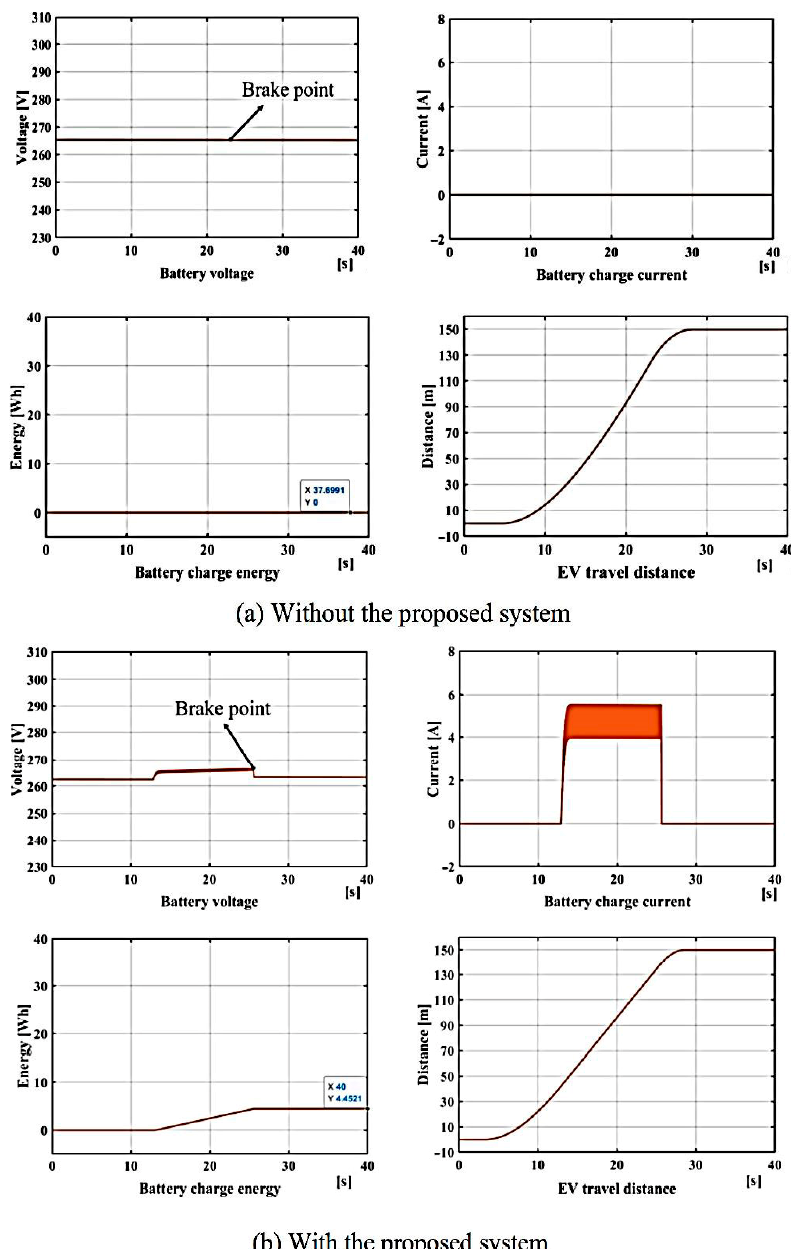
Figure 10. Results of the experiment on the descent with the battery without the proposed system ( a ) and with the proposed system ( b ).